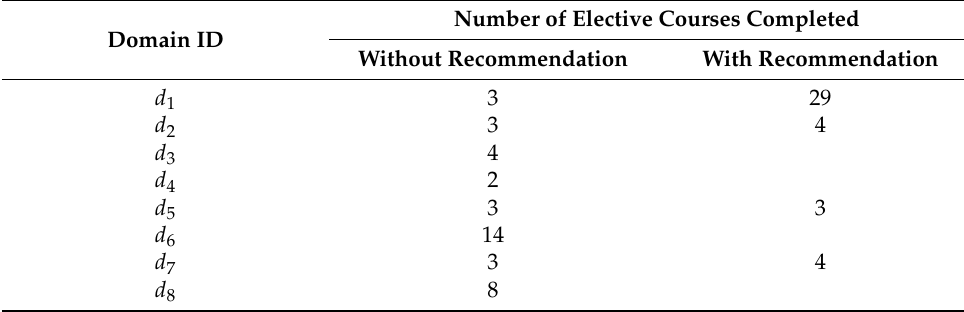
Table 6. Elective course selection patterns and the CGPA